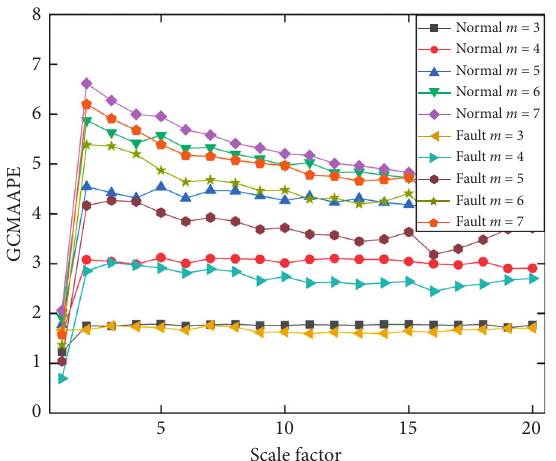
Figure 5: Effect of time delay on the performance of